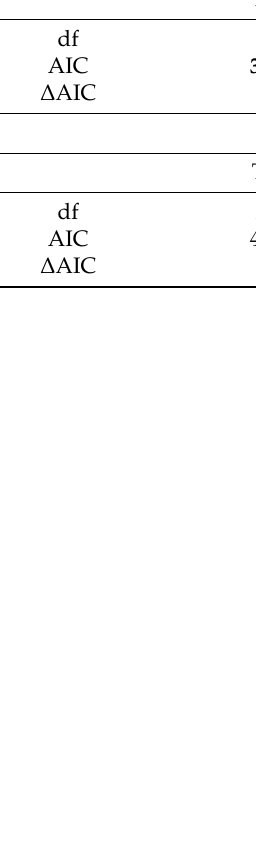
Table 3. Coefficient Estimates for the Body Fat